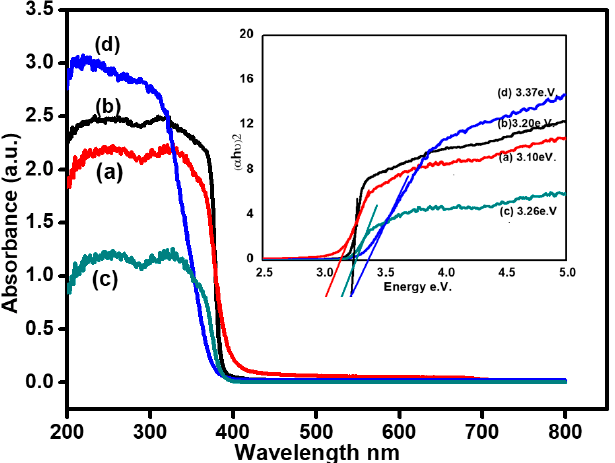
Figure 5. UV-Visible spectrum and UV-diffuse reflectance spectrum of ZnO and TiO 2 as ( a ) FL–ZnO 3.10 eV, ( b ) FL–TiO 2, 3.20 eV. ( c )Pristine ZnO 3.20 eV and ( d ) Pristine TiO 2 3.37 eV.